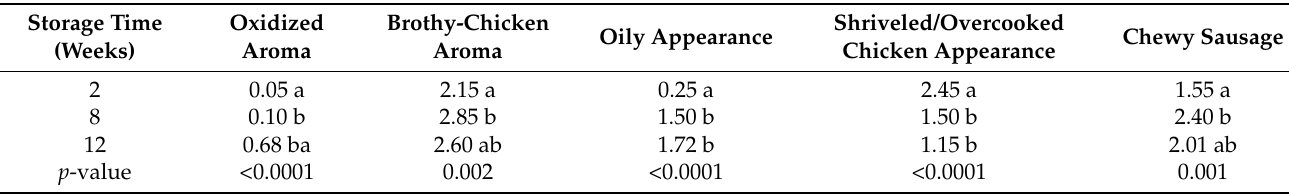
Different letters within a column (a,b) indicate that attribute intensities were different among storage times at p < 0.05 as determined using Tukey’s HSD. These results range between 0 and 3 due to the use of a four-point scale of 0, 1, 2, 3 (absent, low, medium, high). Mean values are collapsed over processing method, replicate and